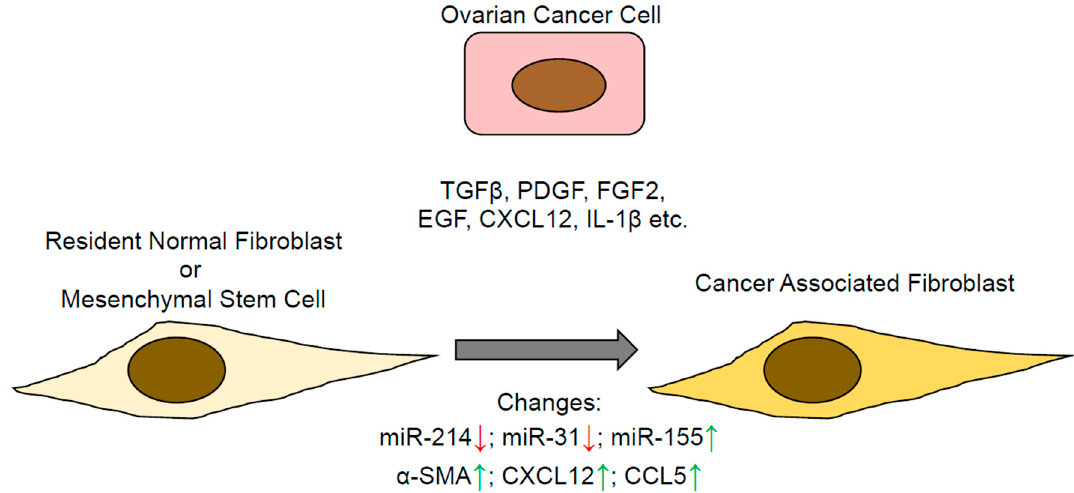
Figure 1. Formation of cancer associated fibroblasts (CAFs) through the reprogramming of resident normal fibroblasts or mesenchymal stem cells by ovarian cancer cells. TGF- β : transforming growth factor beta; PDGF: platelet-derived growth factor; FGF: fibroblast growth factor; EGF: epidermal growth factors; CXCL12: C-X-C Motif Chemokine Ligand 12; CCL5: C-C Motif Chemokine Ligand 5; ↑ : upregulated; ↓ : downregulated.